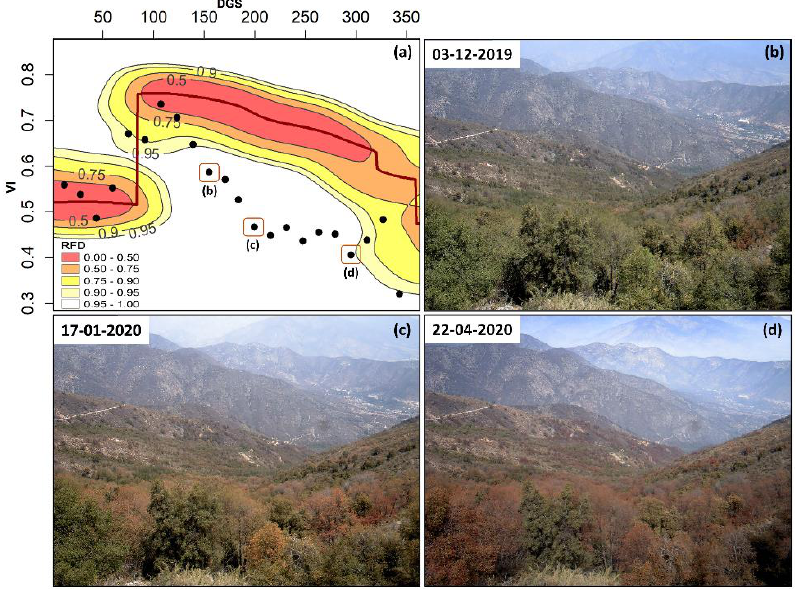
Figure 5. Phenocam photographs of Nothofagus macrocarpa forest in Central Chile ( b – d ) during the extreme 2019 – 20 drought ( a ). Note that the condition of the forest canopy by January 2020 (summer) resembles the typical reddish colour of Autumn.